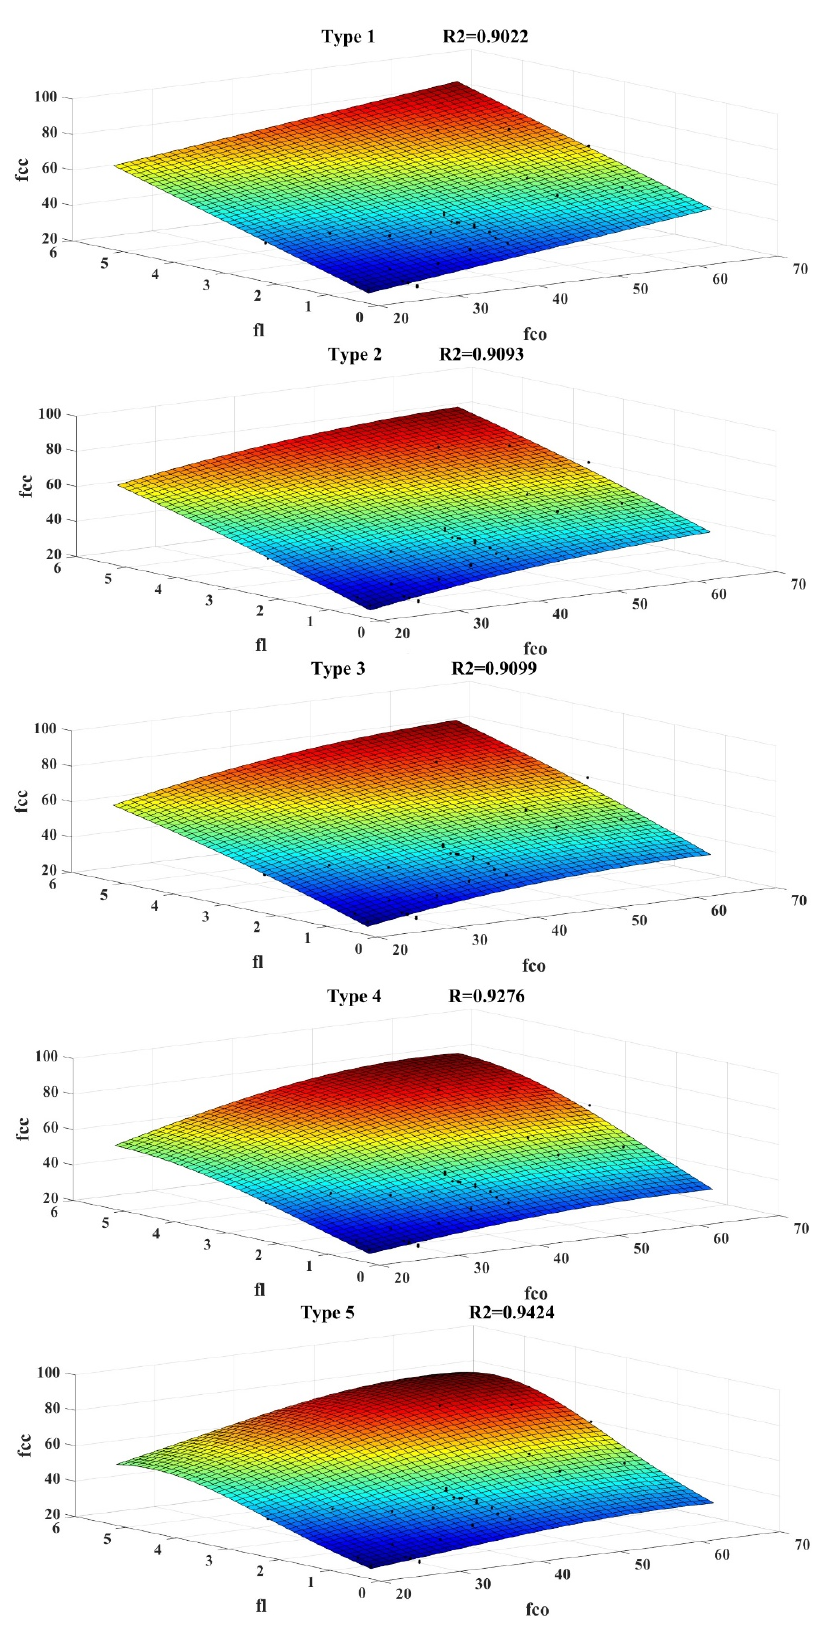
Figure 7. Regression analysis diagrams of the three-dimensional equations for predicting the peak compressive strength of the SMA-confined concrete cylindrical specimens and comparing them with the experimental data.